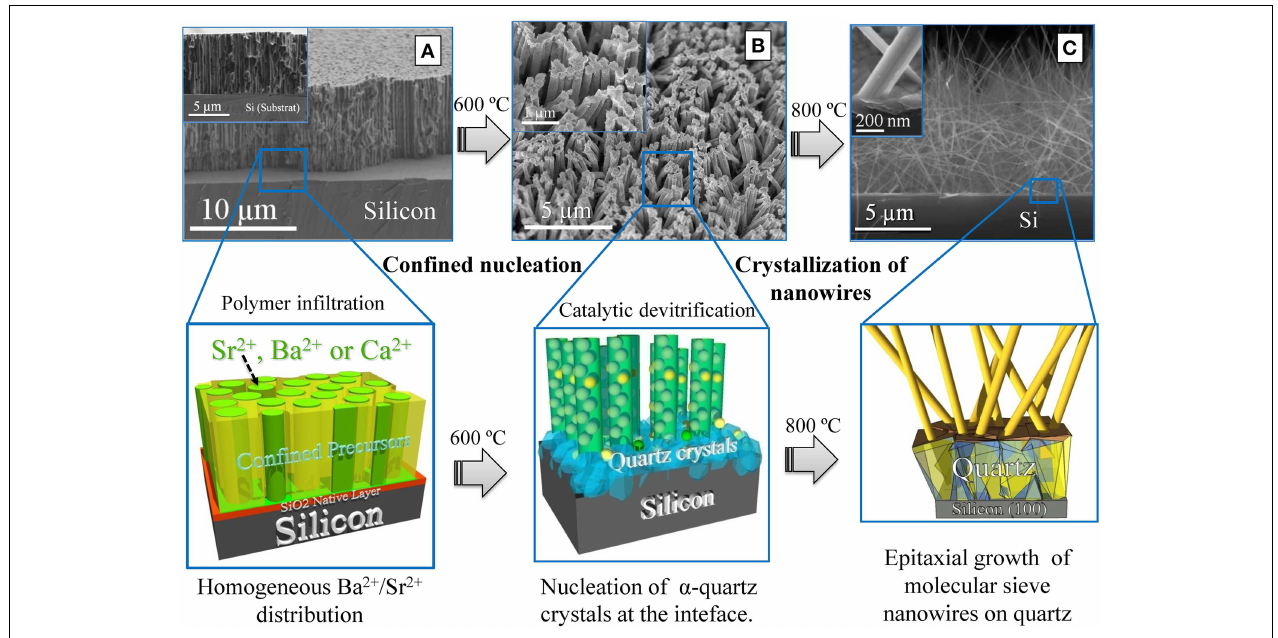
FIGURE 5 | FE-SEM images and graphics (below) representing the intermediary steps during the OMS nanowires epitaxial growth on Si. (A) FE-SEM Cross-sectional image of the porous polymer template after infiltration of nanopores with the precursor solution. At this stage Ba 2 + , Sr 2 + , or Ca 2 + cations are homogenously distributed. (B) FE-SEM image of the